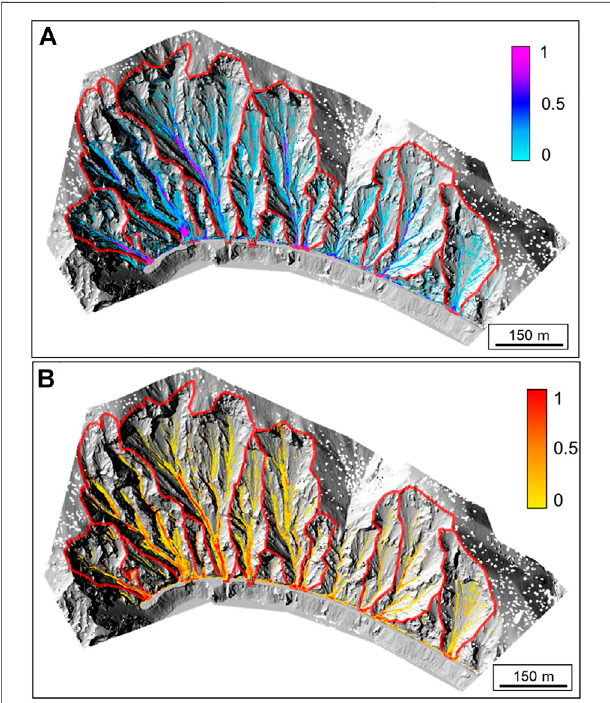
Frontiers in Earth Science |